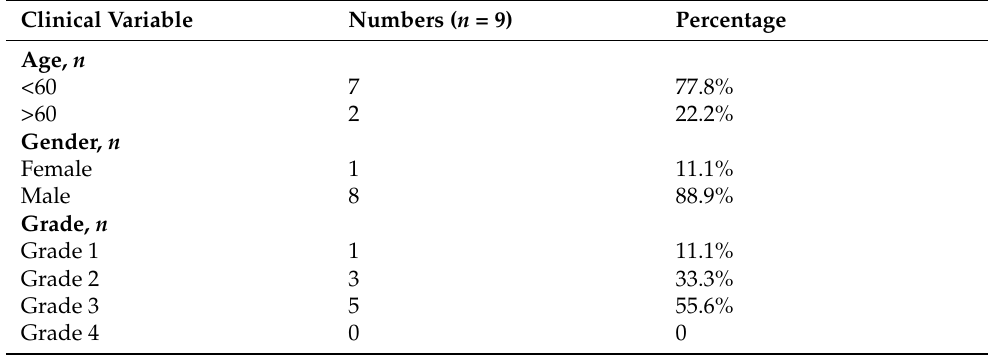
Table 2. The clinical features of patients in the tissue samples recruited for this